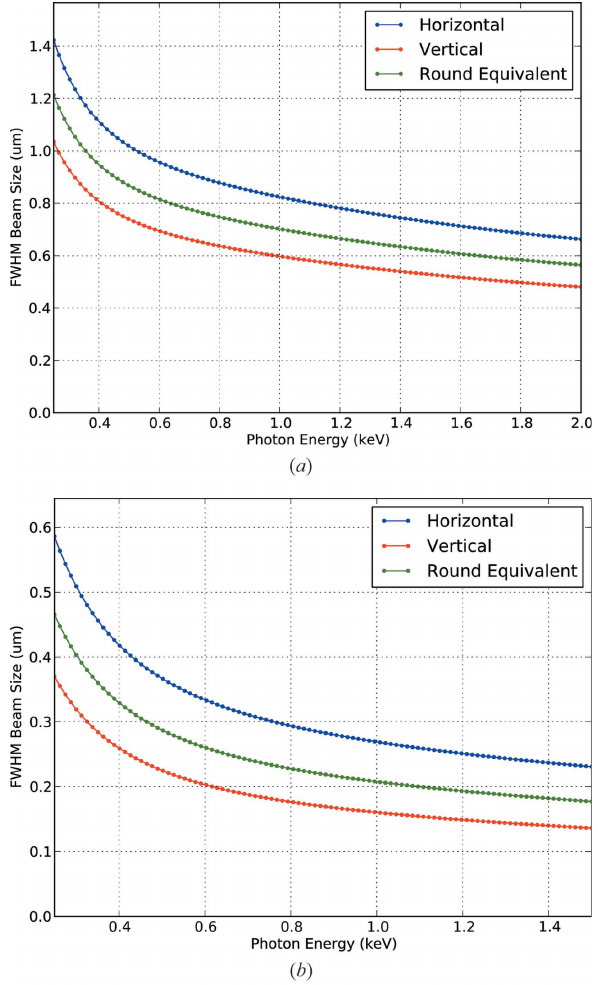
Figure 5 Exemplary smallest achievable focus spot sizes at both IPs in TMO, obtained from calculations based on start-to-end simulations for LCLS-II with 20 pC bunch charge. The top panel refers to the IP1 (NAMASTE) reaching 2 keV. The bottom panel refers to the IP2 (DREAM) chamber and can reach 1.4